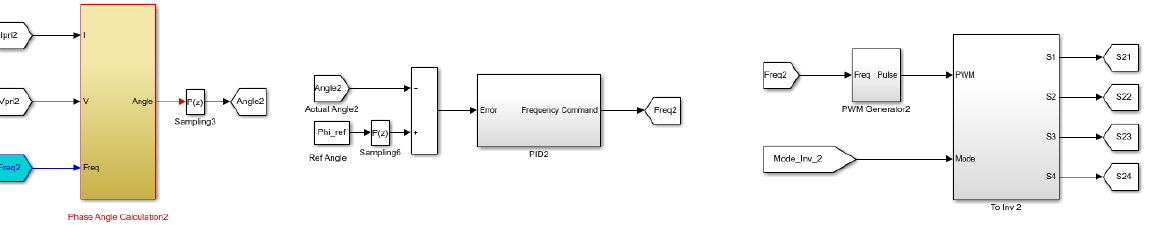
Figure A3. Each coil is modeled as a current source.